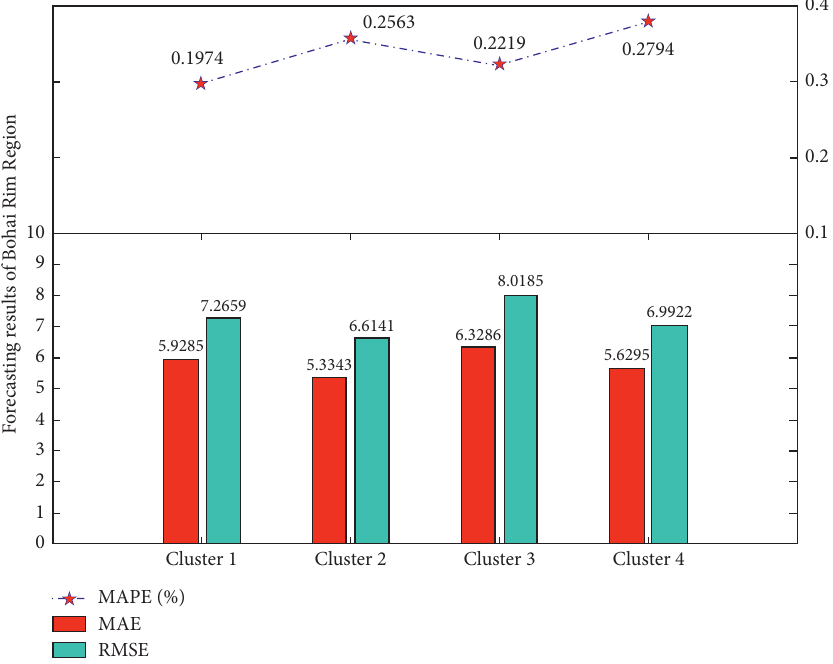
Figure 11: The specific results of PM2.5 prediction by difference equation